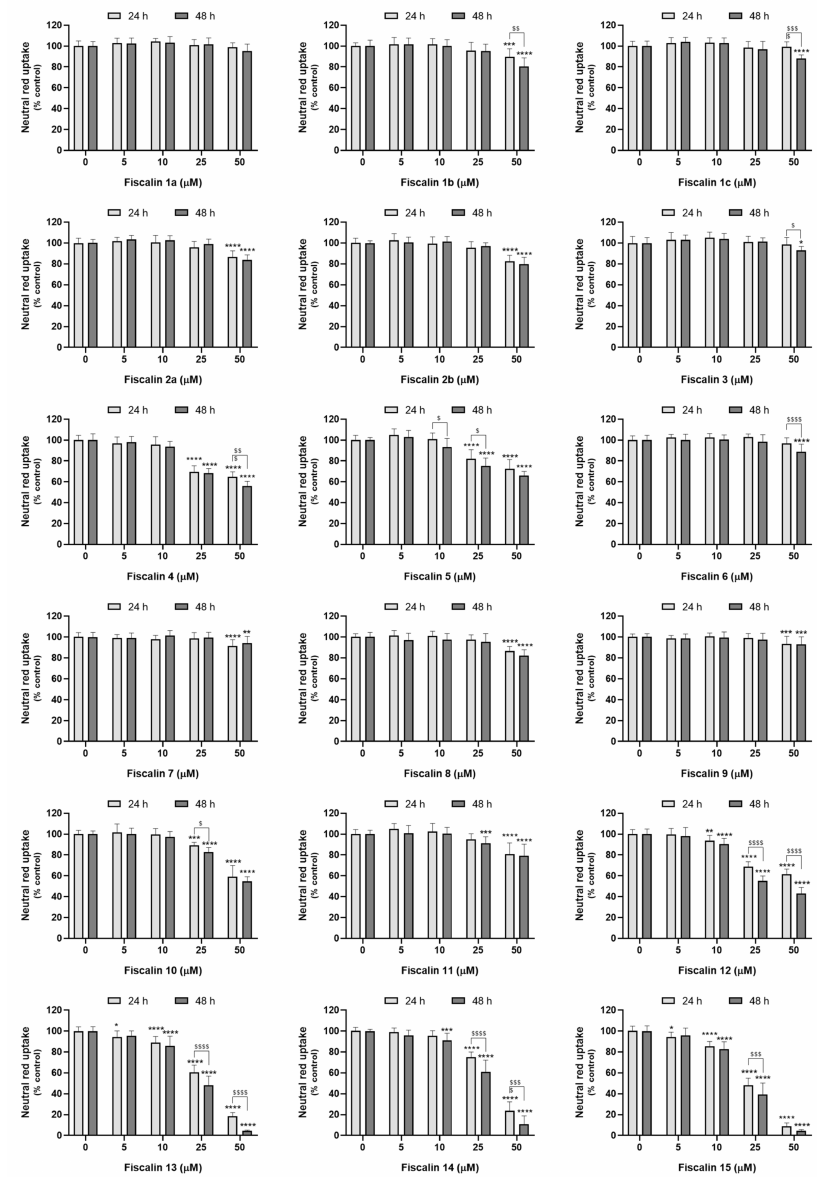
Figure 2. Fiscalins (0–50 µ M) cytotoxicity towards differentiated SH-SY5Y cells, evaluated by the neutral red uptake assay, 24 and 48 h after exposure. Results are presented as mean ± SD from at least four independent experiments, performed in triplicate. Statistical comparisons were made using two-way ANOVA, followed by Tukey’s multiple comparisons test (at each timepoint, for comparisons between concentrations) or by Sidak’s multiple comparisons test (for each concentration, for comparisons between timepoints). In all cases, p values < 0.05 were considered significant [* p < 0.05; ** p < 0.01; *** p < 0.001; **** p < 0.0001 versus control (0 µ M), at each timepoint; $ p <